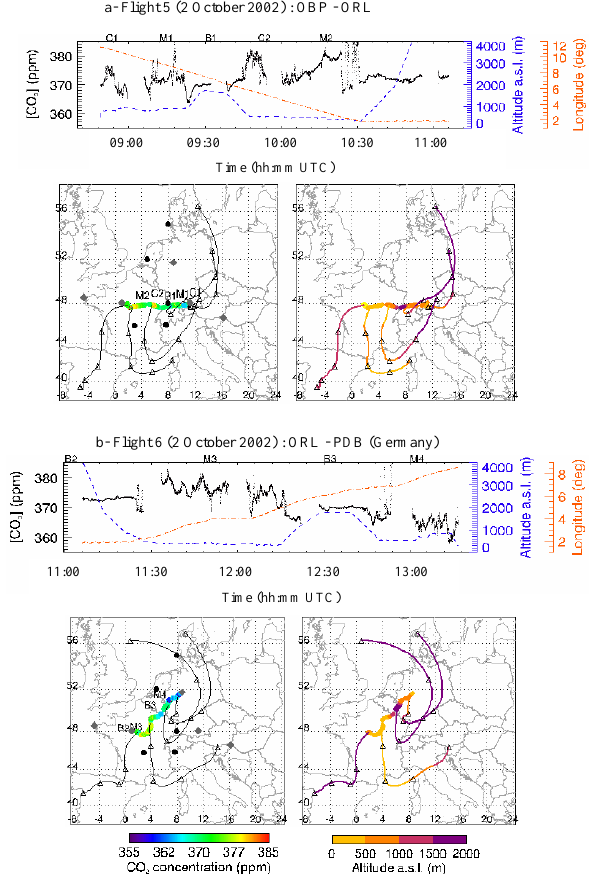
Fig. 6. (a, b) Back-trajectories computed over 96h for flights 5 and 6. The distance between 2 triangles is 24h. Left panels show CO 2 concentrations along the flight path and back-trajectories. Right panels show the altitude of the flight, and back-trajectories colored according to air mass altitude. Black circles represent ground sta- tions named in Fig. 1. Altitude is given in meters above the sea level (m a.s.l.). Note that some of the back-trajectories are outside the latitude and longitude chosen borders, but these are so diluted that they do not give any relevant